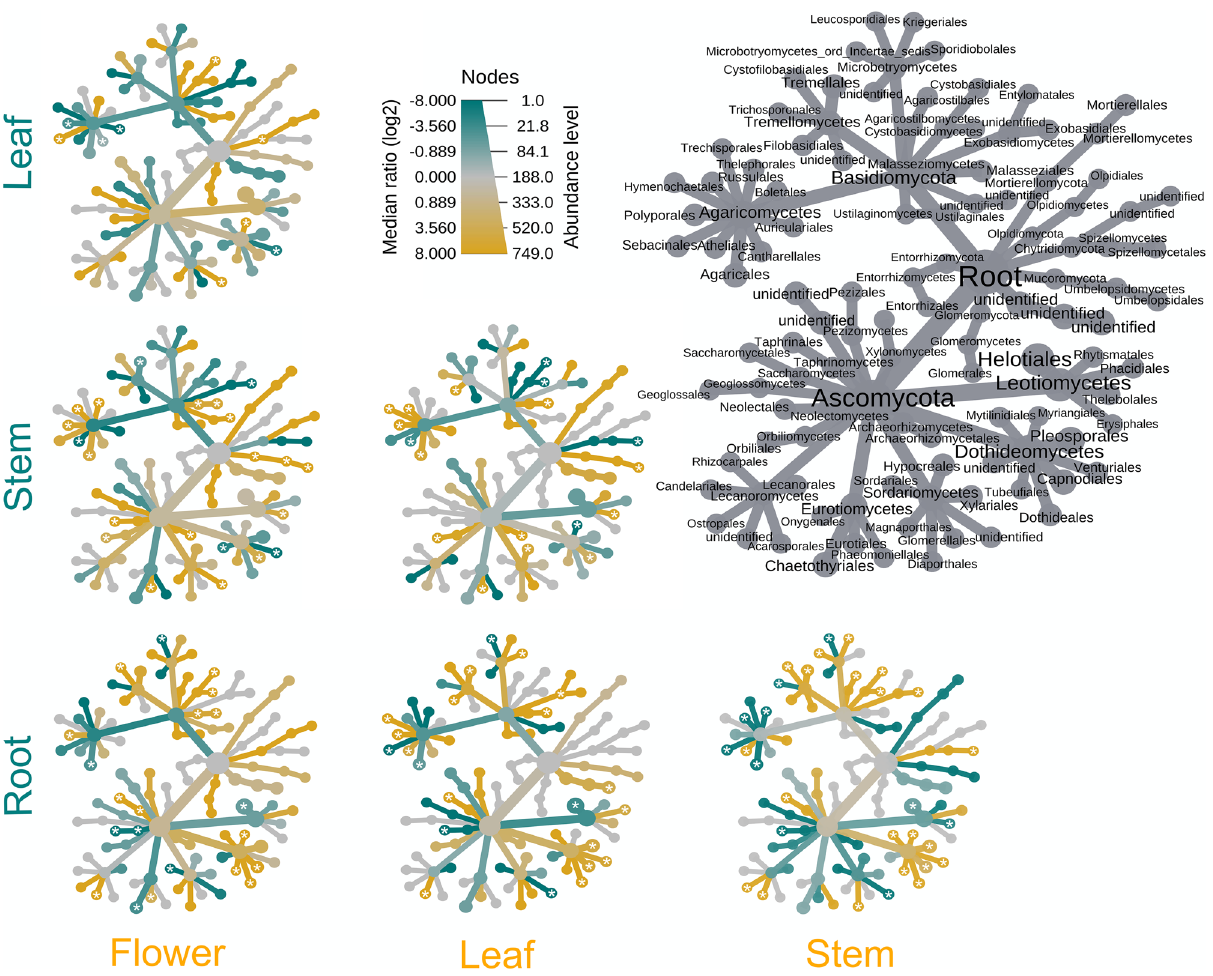
Figure 3. Heat tree matrix depicting the different taxa abundance among the plant organs, for all orders in the dataset. The size of the nodes in the gray cladogram (right) represents the number of OTUs identified at that taxonomic level. The small cladograms show the pairwise comparisons among the organs: a yellow node indicates a higher abundance of the taxon in the organ indicated in yellow than in the organ indicated in green. A green node indicates the opposite. Taxa identified as differently represented, statistically supported by the Wilcoxon test (p < 0.05), are tagged with a white